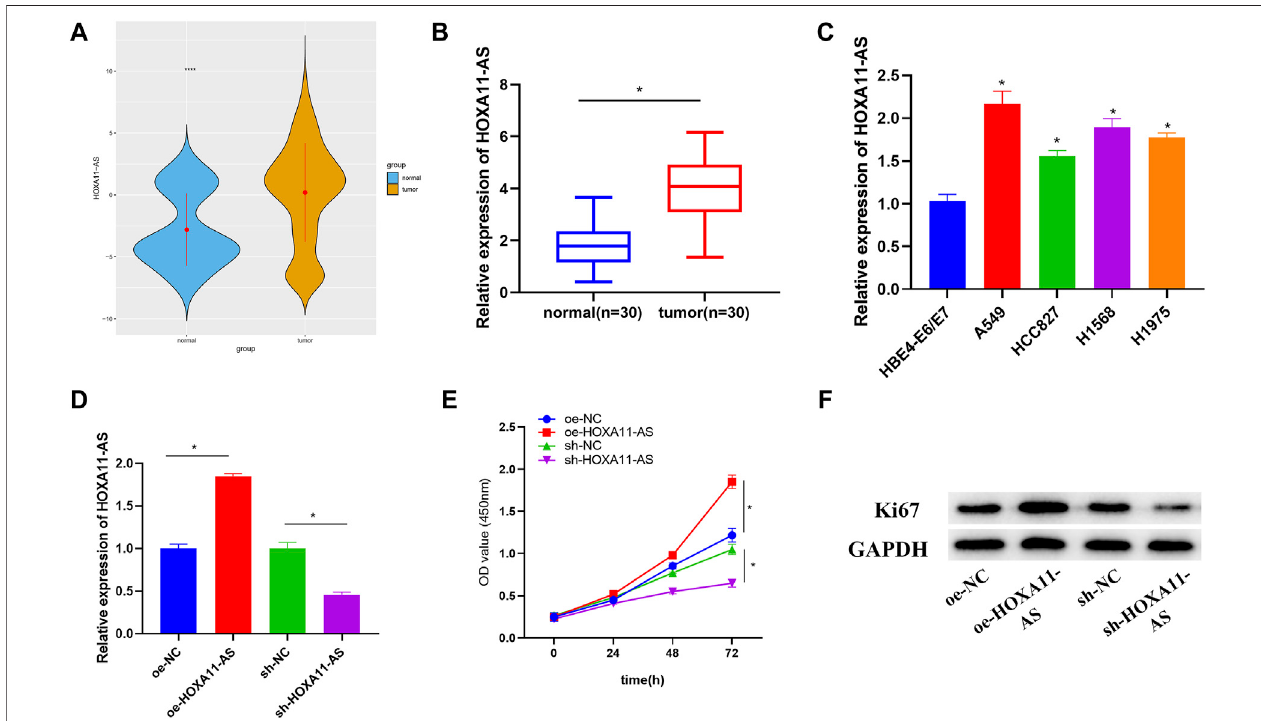
FIGURE 1 | Upregulated HOXA11-AS in LUAD with implications on LUAD cell proliferation. (A) TCGA-LUAD dataset was employed to detect HOXA11-AS expression(bluerepresentsnormaltissuewhileorangerepresentstumortissue). (B) HOXA11-ASexpressionwasfurthermeasuredinLUADtissue( n =30)andadjacent tissue ( n = 30). (C) By qRT-PCR, HOXA11-AS expression in normal cell line and LUAD cell lines was presented. (D) qRT-PCR con fi rmed the transfection ef fi ciency of HOXA11-AS. (E) Cell viability was observed through CCK-8. (F) Expression of cell proliferation-related protein Ki67 was exhibited via Western blot; * p < 0.05.